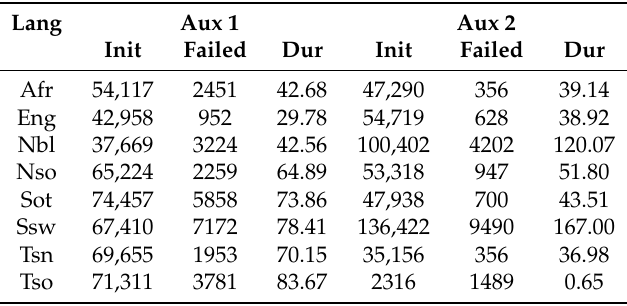
Table 1. Total number of initial (Init) auxiliary recordings (Aux1 and Aux2), number of failed phone alignments (failed) and duration (dur) in hours of additional data per